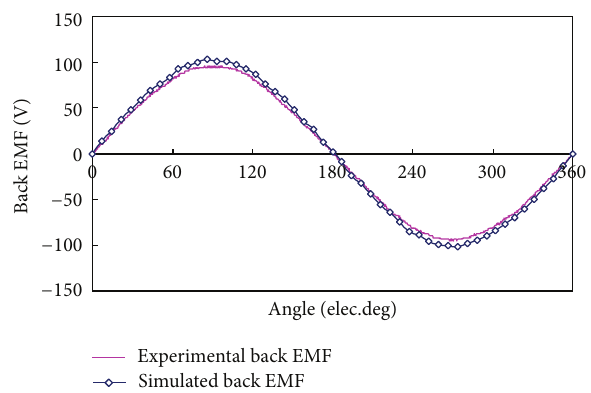
Figure 9: Comparison of back EMF variations between FEA and experimental results.